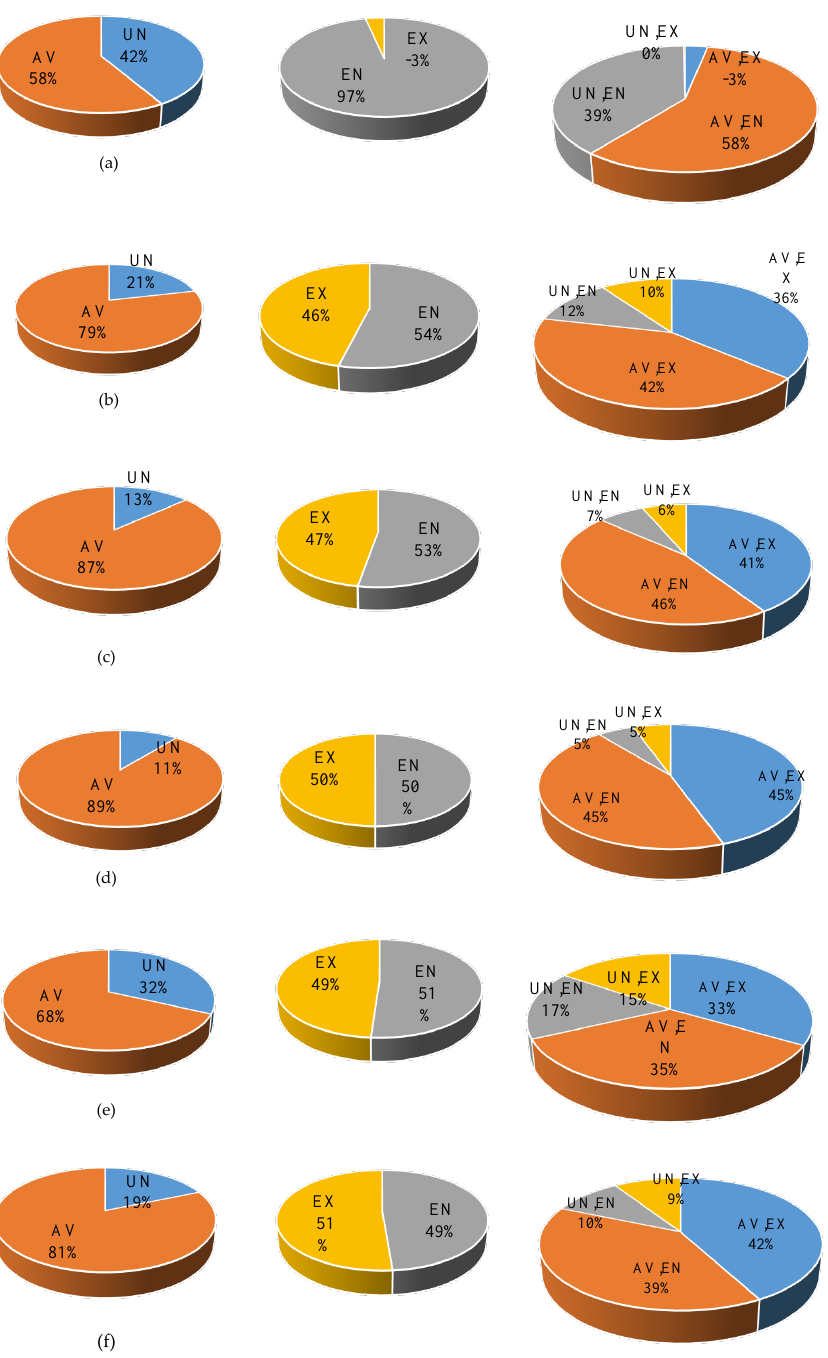
Figure 5. Splitting exergy destruction rates of components: ( a ) the evaporator, ( b ) turbine, ( c ) pump1, ( d ) pump2, ( e ) feed-water heater and ( f ) condenser in the SRORC system.